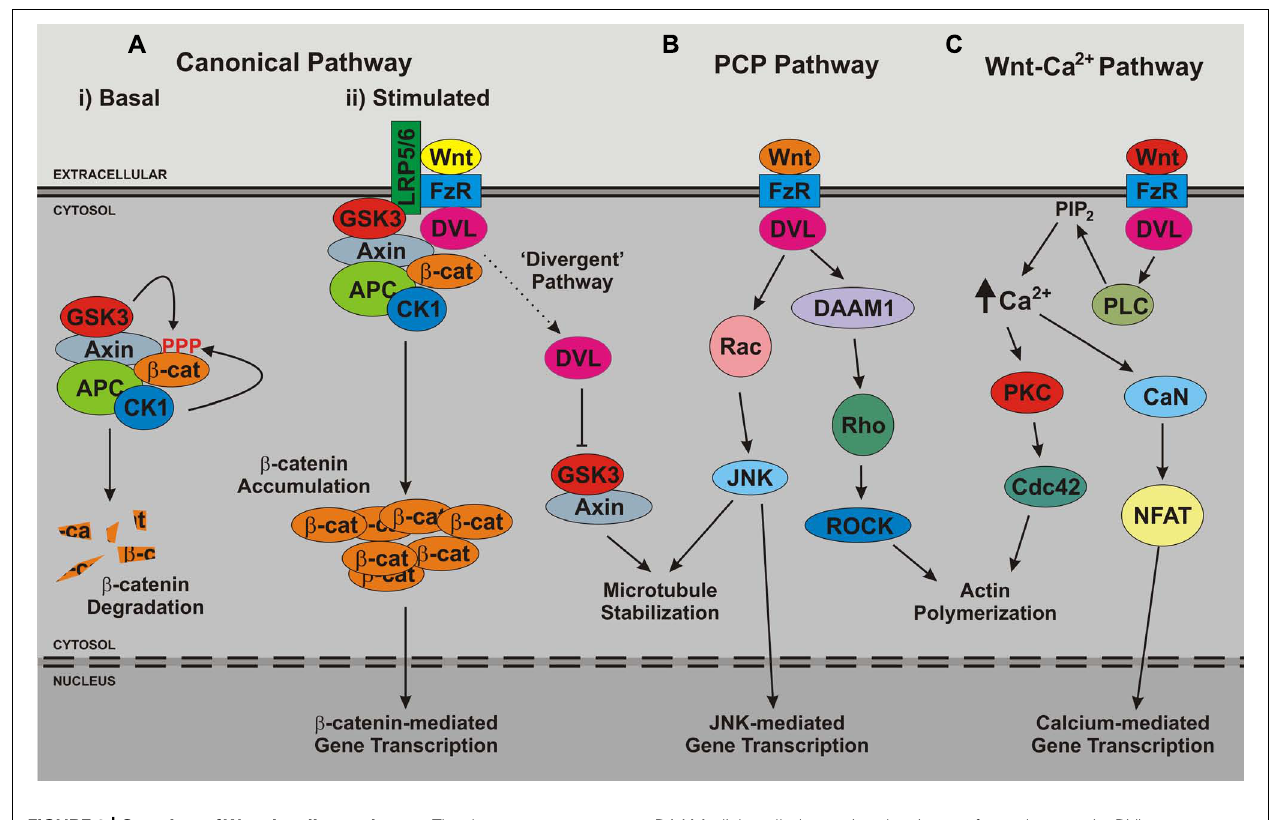
FIGURE 3 | Overview ofWnt signaling pathways. The three major branches ofWnt signaling – (A) the canonical, (B) planar cell polarity (PCP), (C) andWnt-Ca 2 + – pathways are illustrated. Note that in growing neurites a further branch has been reported, the so-called divergent canonical pathway, which impacts upon microtubule stability. APC, adenomatous polyposis coli; CaN, calcineurin; CK1, casein kinase 1;